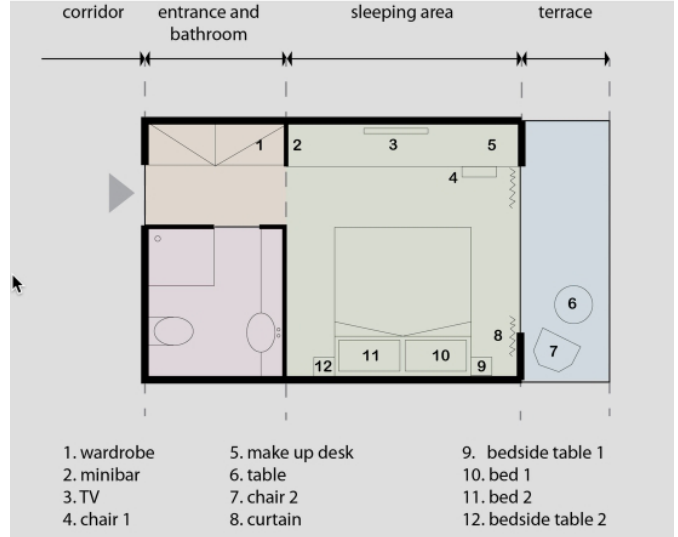
Figure 9. Functional areas in a